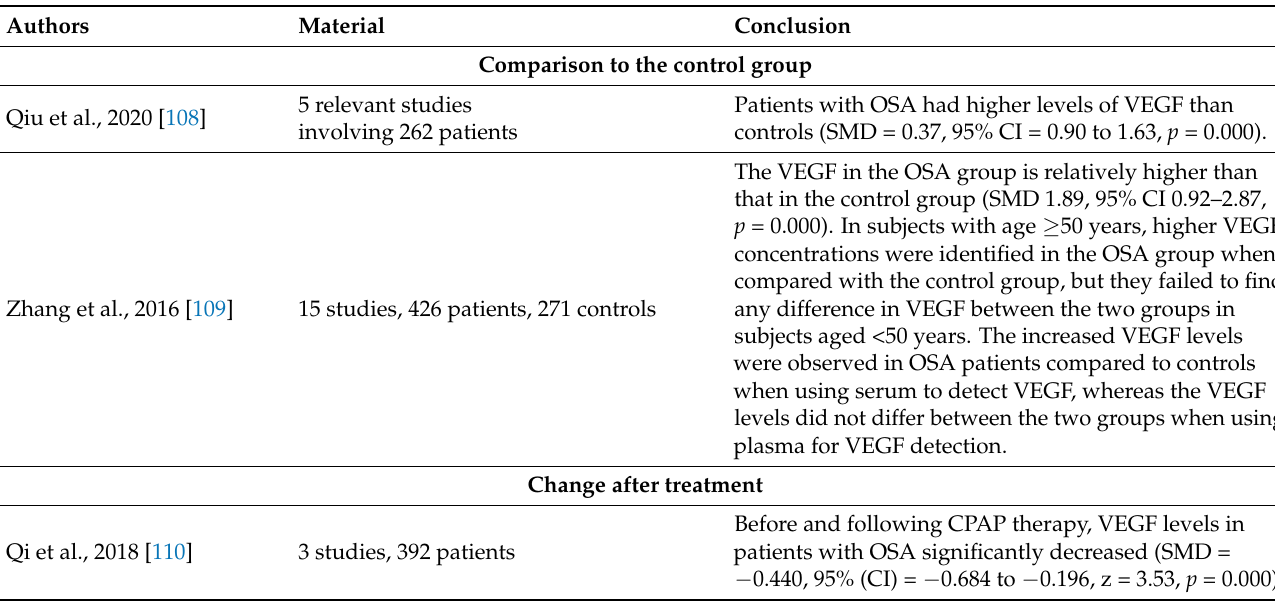
Table 8. Meta-analyses of VEGF studies in OSA